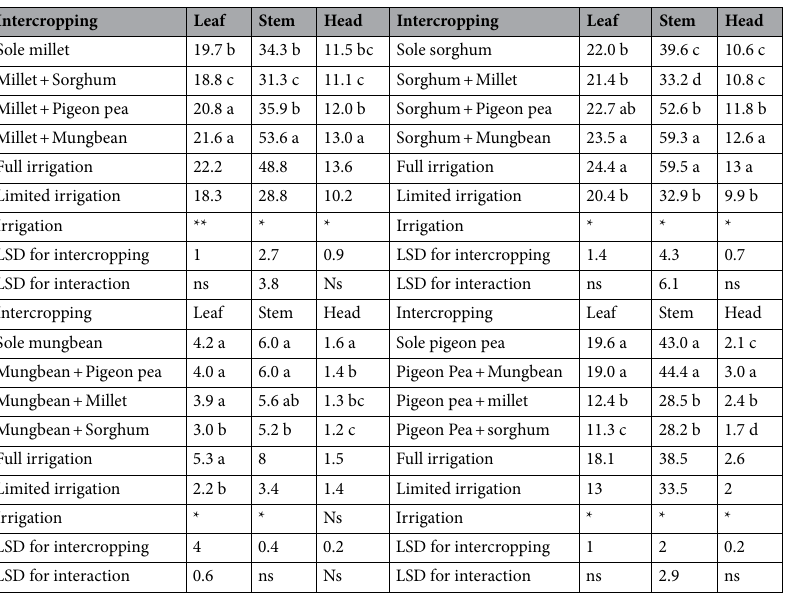
Table 5. Dry matter partitioning (g plant −1 ) at anthesis of summer crops as affected by intercropping and irrigation